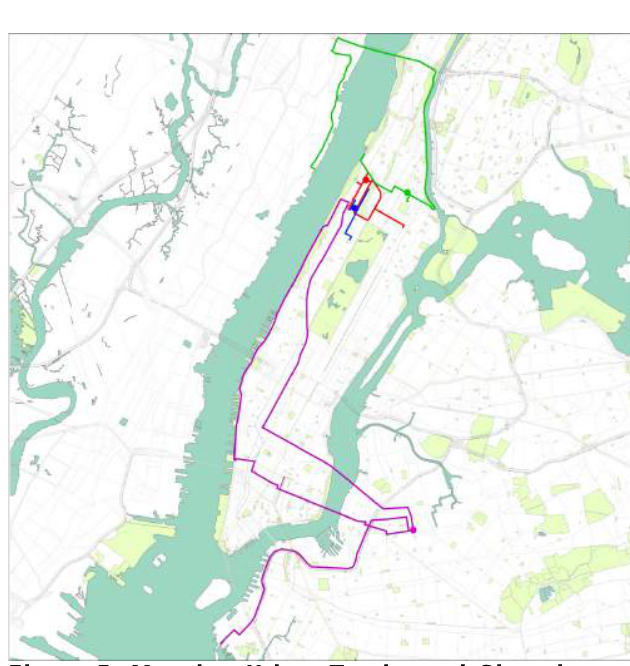
Figure 5: Mapping Urban Tracks and Shopping Purple and green tracks are car owners; red and blue walk or bike. Image: Cezar Nicolescu, Lynnette